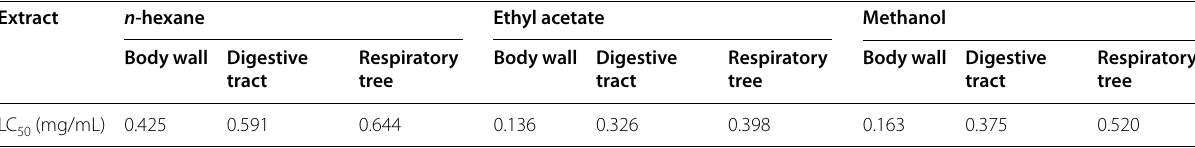
Table 3 Toxicity effects of extracts from sea cucumber S. hermmanni against brine shrimp A. salina larvae Extract n ‑hexane